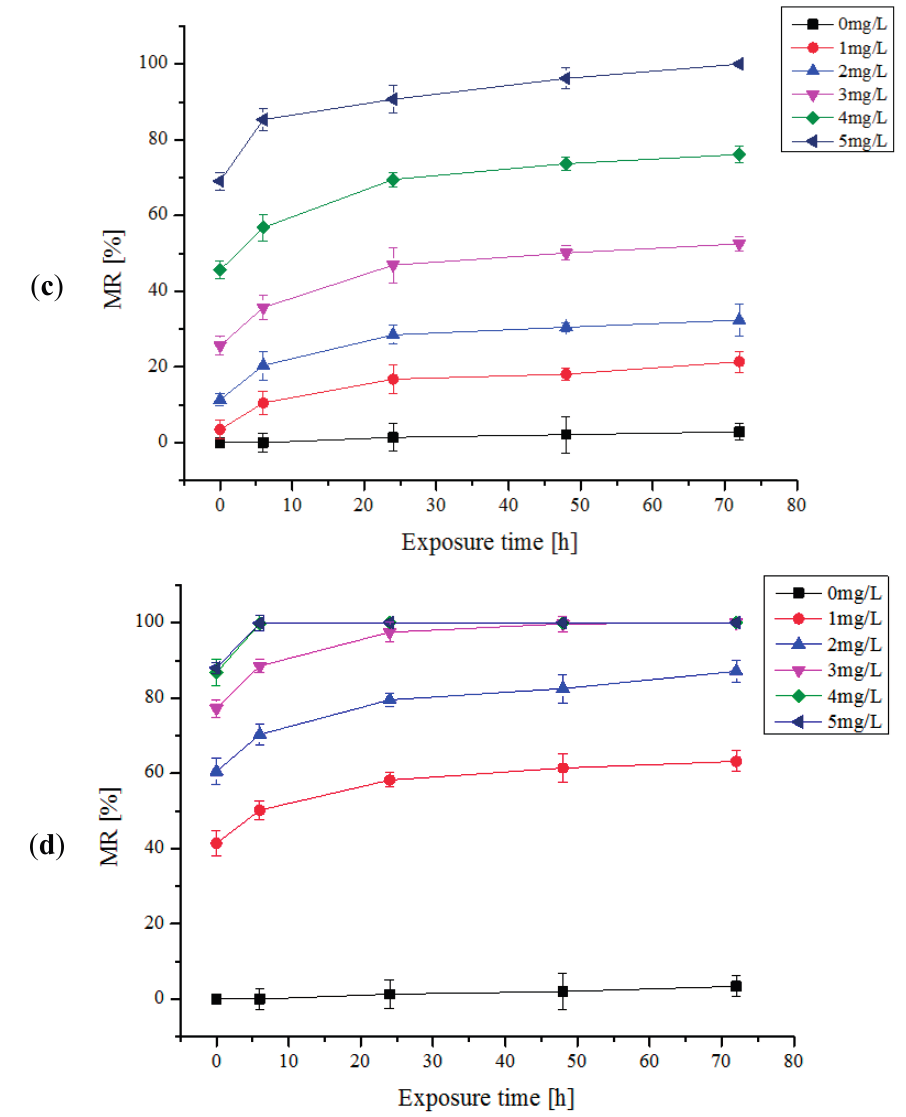
Figure 1. ( a ) The mortality rates (MRs) of Platymonas subcordiformis by one trial injection of electrolytic products; ( b ) The MRs of Chlorella vulgaris by one trial injection of electrolytic products; ( c ) The MRs of Prorocentrum micans by one trial injection of electrolytic products; ( d ) The MRs of Karenia mikimotoi by one trial injection of electrolytic